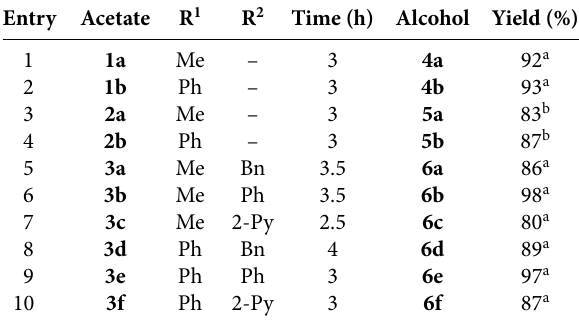
Table 1. Acidic alcoholysis of acetates 1a,b , 2a,b , and 3a–f